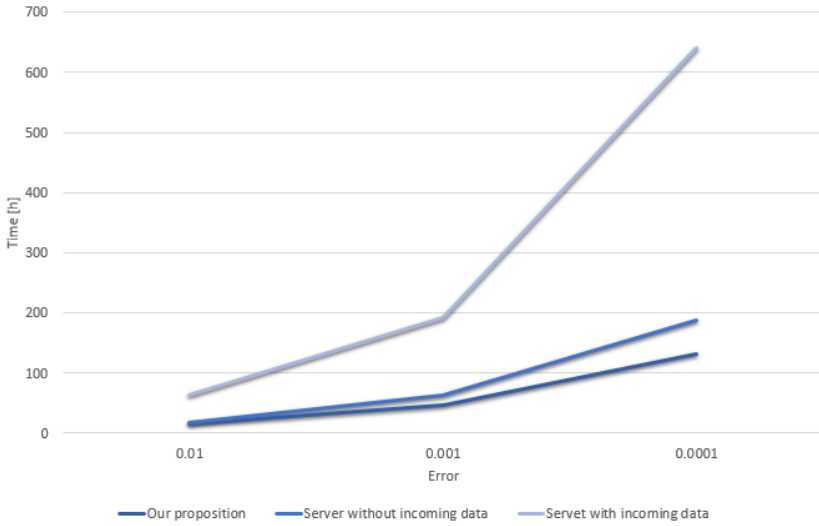
Figure 5. Time needed to train classifier (with 4 hidden layers) to particular